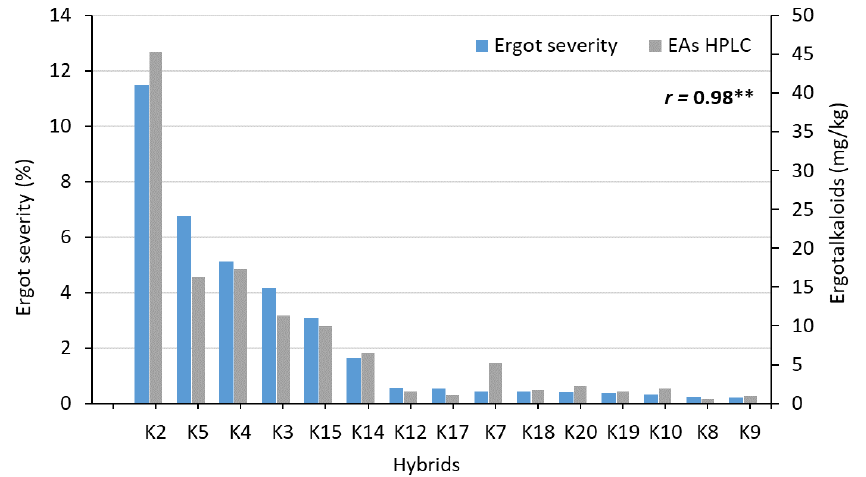
Figure 2. Association between ergot severity (%) and ergot alkaloids (EAs, mg/kg) determined by HPLC across 2 environments (OLI18, OLI19) for 15 single crosses after inoculation with C. purpurea ( r = coefficient of correlation, **: significant at p < 0.01).